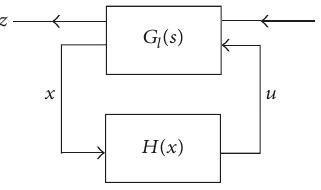
Figure 5: The system with Hill feedback model